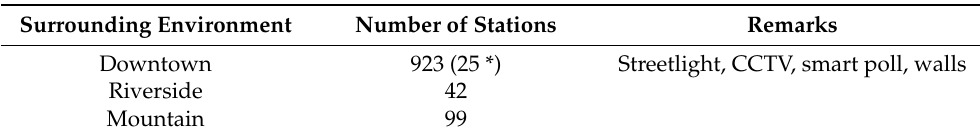
Table 1. Number of stations with respect to the surrounding